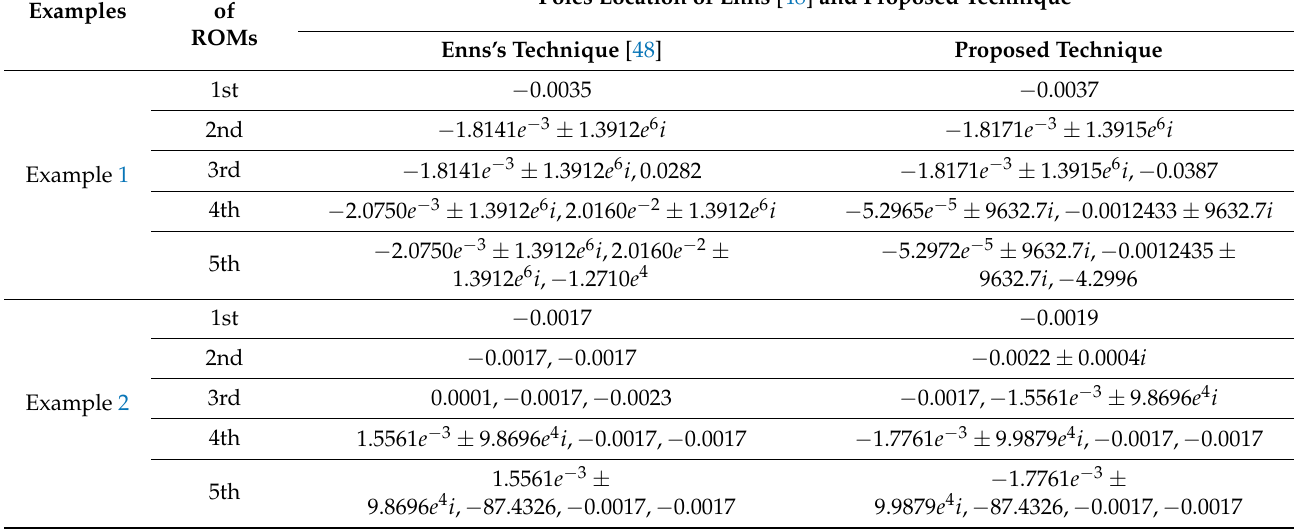
Table 3. Poles locations of ROMs obtained using frequency weighted